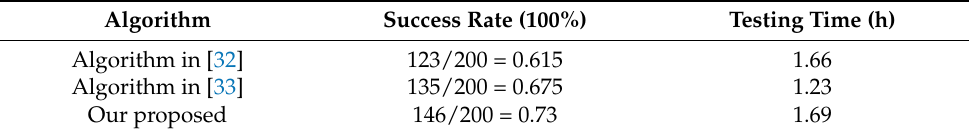
Table 9. Comparison of test results of each algorithm in simulation Figure 6c.